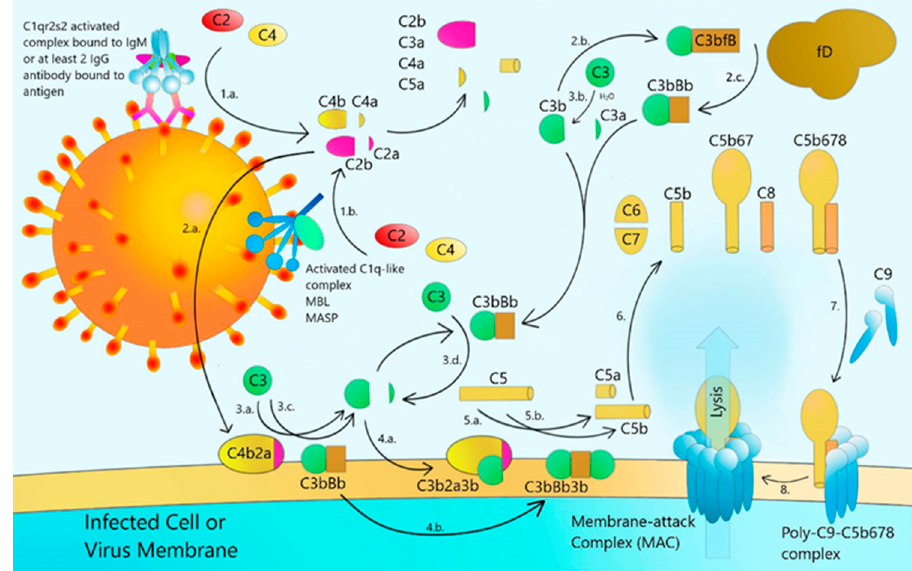
Figure 5. Schematic diagram of how coronavirus stimulates the complement cascade. 1.a. C1qr2s2 bound to IgM or at least 2 IgG antibodies binds to antigen. C1qr2s2 is activated and cleaves C2 and C4 into C2a, C2b, C4a, and C4b. 1.b. Activated C1q-like complex bound to MBL-MASP binds to mannose-glycosylated antigen and cleaves C2 and C4 into C2a, C2b, C4a, and C4b. 2.a. C4b and C2a bind to form C4b2a C3 convertase. 2.b. C3b binds to fB. 2.c. C3bfB is cleaved into C3bBb. 3.a. C3 is cleaved into C3a and C3b by C4b2a. 3.b. C3 is hydrolytically cleaved spontaneously into C3a and C3b. 3.c. and 3.d. C3 is alternatively cleaved by C3bBb either freely or on membrane surface. 4. C3b binds to C4b2a to form C5 convertase C4b2a3b. 4.b. C3b binds to C3Bb to form C3bBbC3b alternative C5 convertase. 5.a. C4b2a3b cleaves C5 into C5a and C5b. 5.b. C3bBbC3b cleaves C5 into C5a and C5b. 6. C5b binds to C6, C7, and C8 to form C5b678. 7. C9 is recruited to antigen presenting membranes to form poly-C9 and binds to C5b678 8. MAC is formed, and lysis